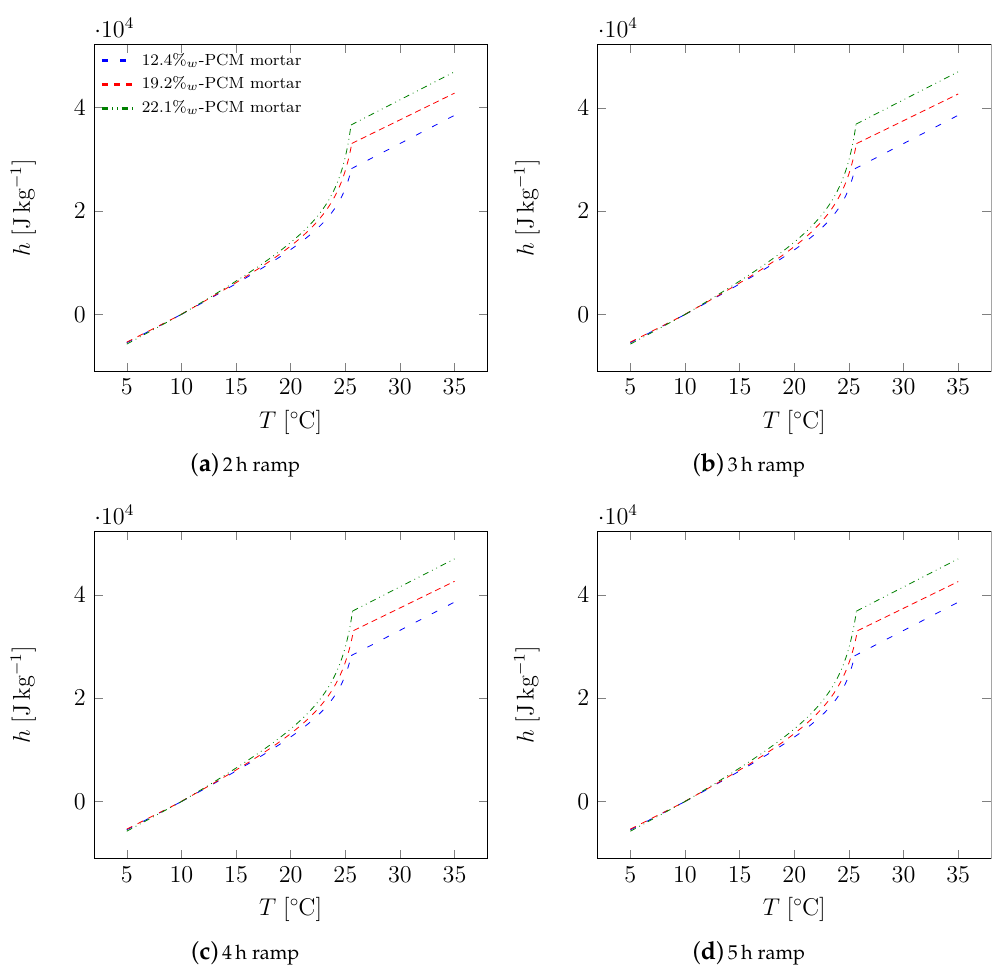
Figure 9. Comparisons of the identified enthalpy functions for all the heating/cooling ramps ( n.b. unique formulation pertaining for both fusion and